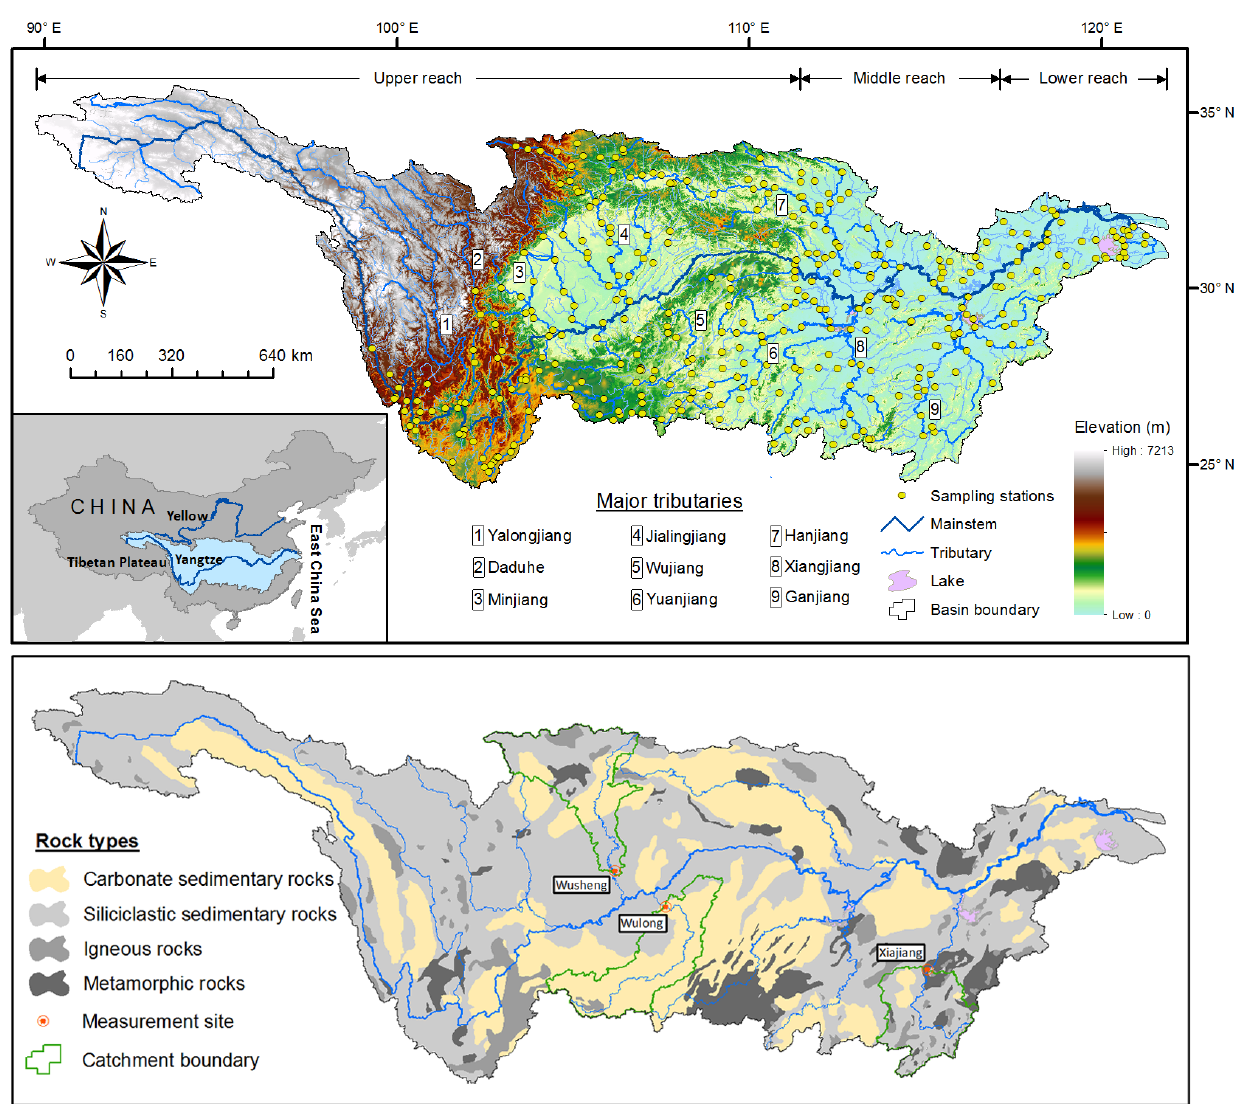
Figure 1. Maps of the Yangtze River basin showing sampling stations (top) and rock compositions (bottom). Rock information is modified from Chen et al. (2002) and Chetelat et al.